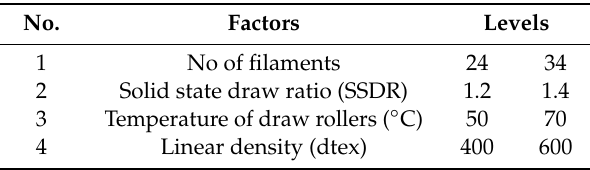
Table 3. Factors and their levels.